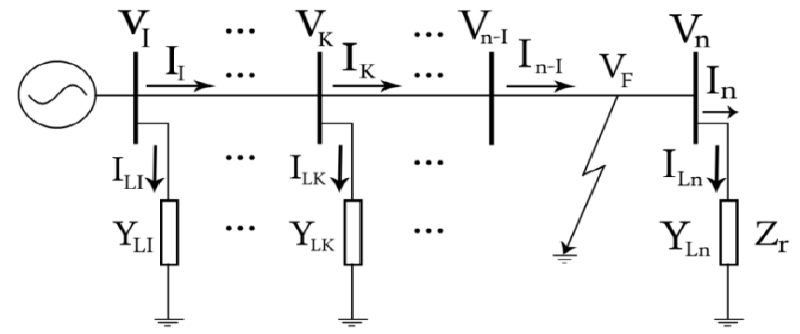
R f a Figure 4. Circuit diagram of a sample section in the presence of fault with distance x from the beginning of the feeder. Step 7 . Checking if the algorithm is converged? If yes, the algorithm is terminated and the value of x is printed; otherwise, go to Step 8 . Step 8 . Determining the voltage of fault point again.